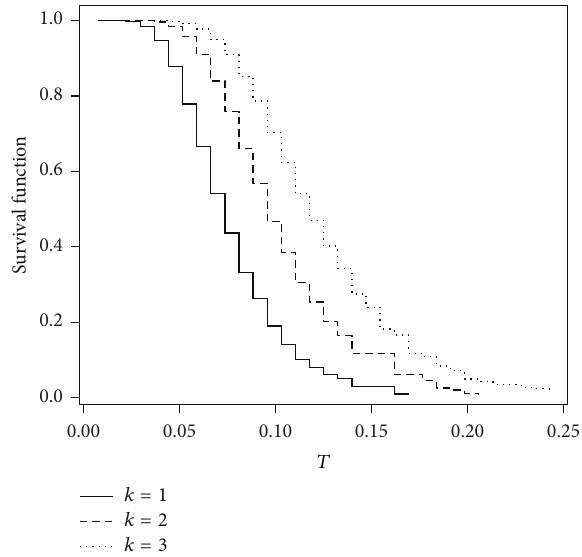
Figure 7: Two-sample predictive survival function for real data set.